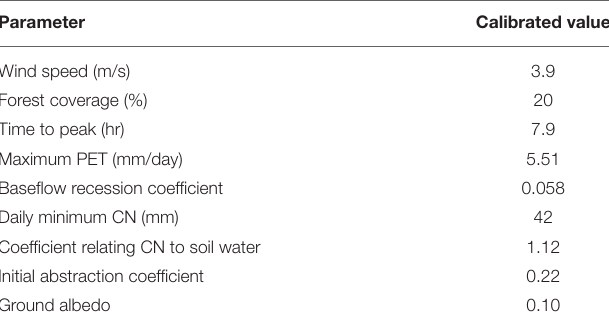
TABLE 1 | Calibrated parameter values obtained by running